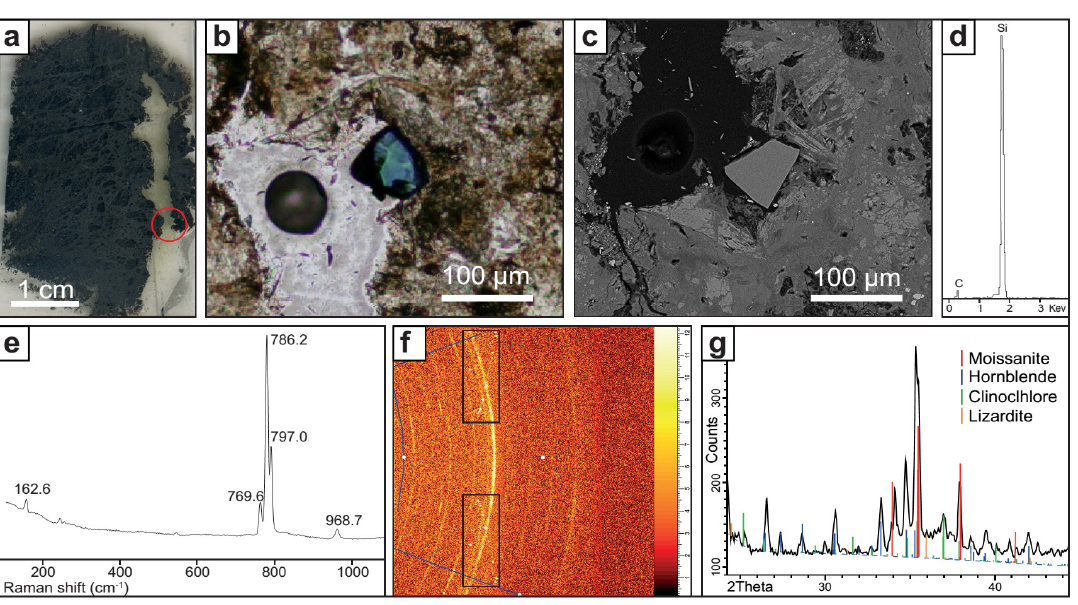
Figure 7. Moissanite crystal hosted in the chromitite altered silicate matrix: ( a ) Thin section containing the moissanite crystal in images ( b , c ). The location of the moissanite crystal in the thin section is showed with a red circle; ( b ) Transmitted light optical microscope image of the moissanite crystal. Note that the crystals show the typical natural moissanite blue color; ( c ) Backscattered electron (BSE) image of the same moissanite crystal in ( b ); ( d ) Energy‐Dispersive Spectroscopy (EDS) spectra of the moissanite crystal of images ( b , c ), showing qualitatively its chemical composition; ( e ) Raman spectra of the moissanite crystal; ( f ) Single crystal X-ray microdiffraction pattern of moissanite; ( g ) Integration of the diffraction pattern with peak identification.